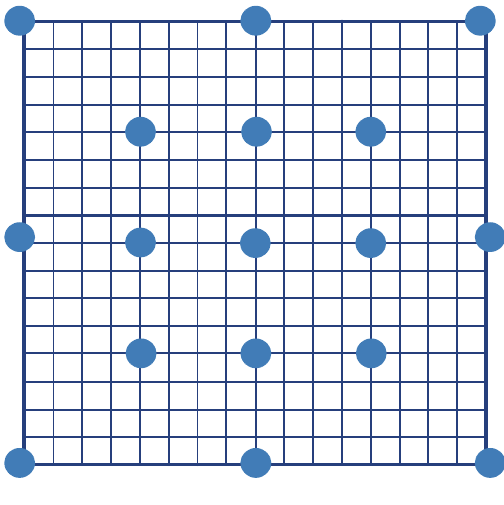
Figure 3. Modified three-step